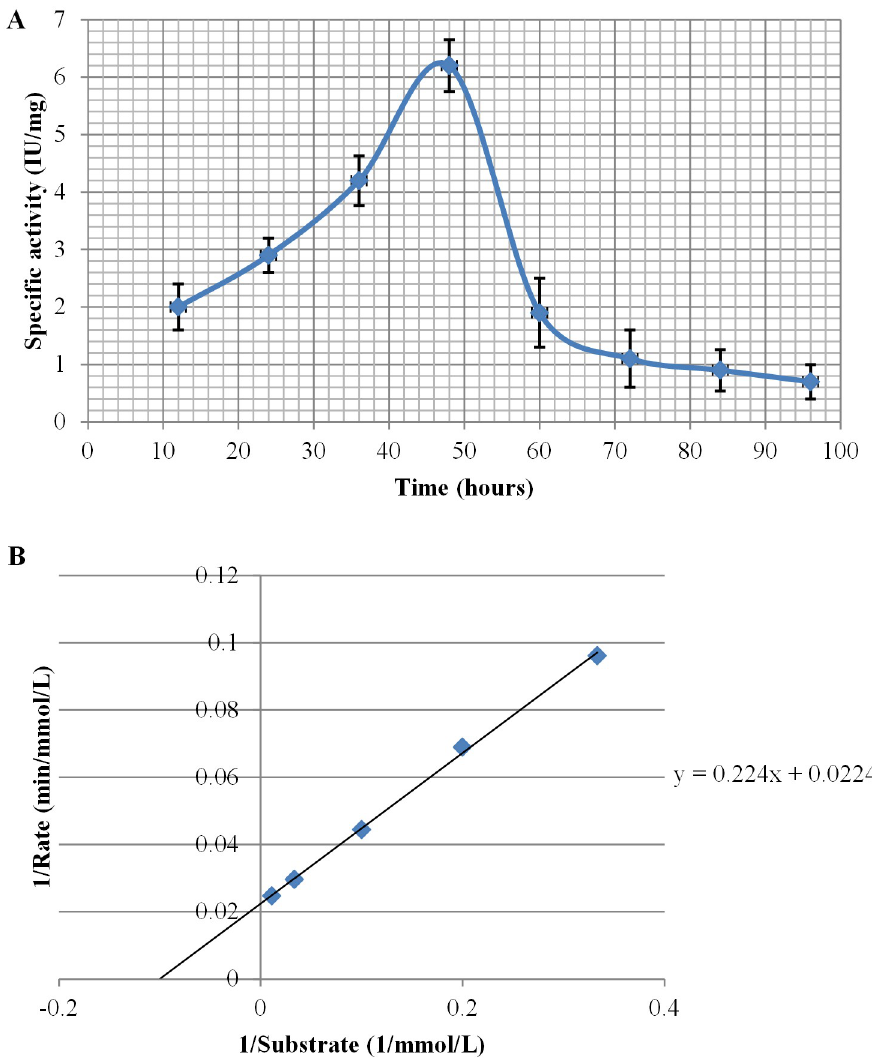
Fig 2. Specific activity of chitinase in Curtobacterium sp. GD1 cell-free culture supernatant measured at 12 hours intervals (A); and Lineweaver–Burk equation of enzyme kinetics (B).